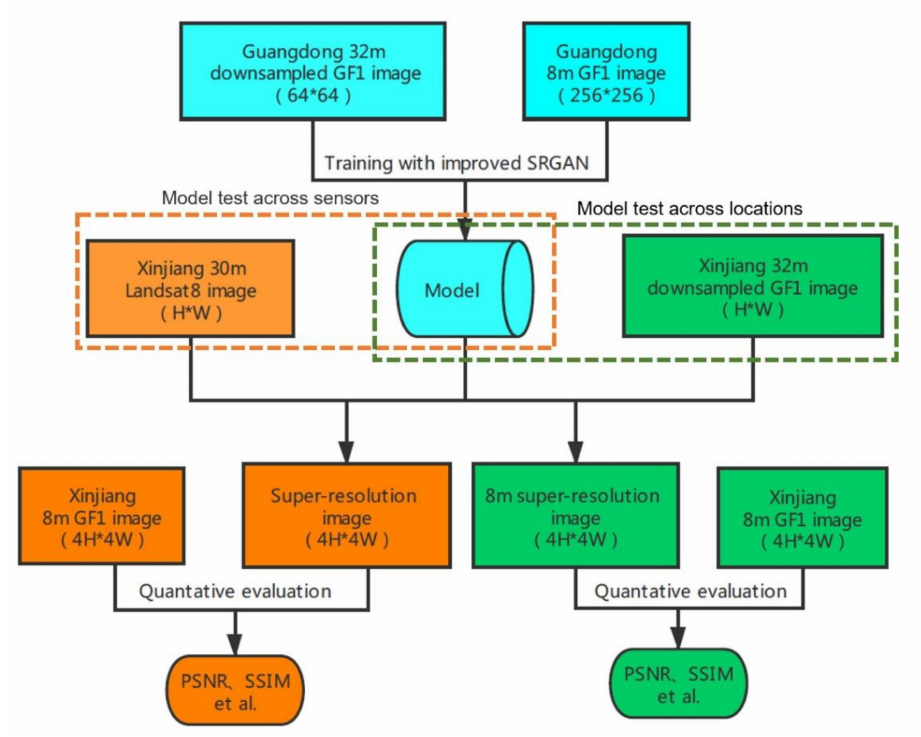
Figure 1. The workflow of the